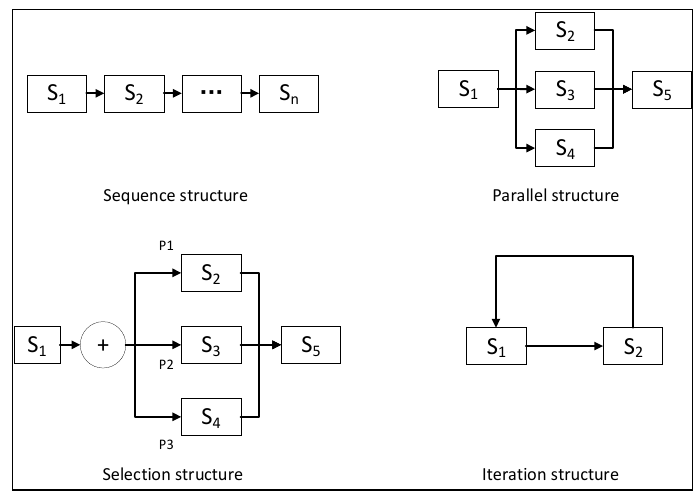
Figure 5. Types of service invocation.